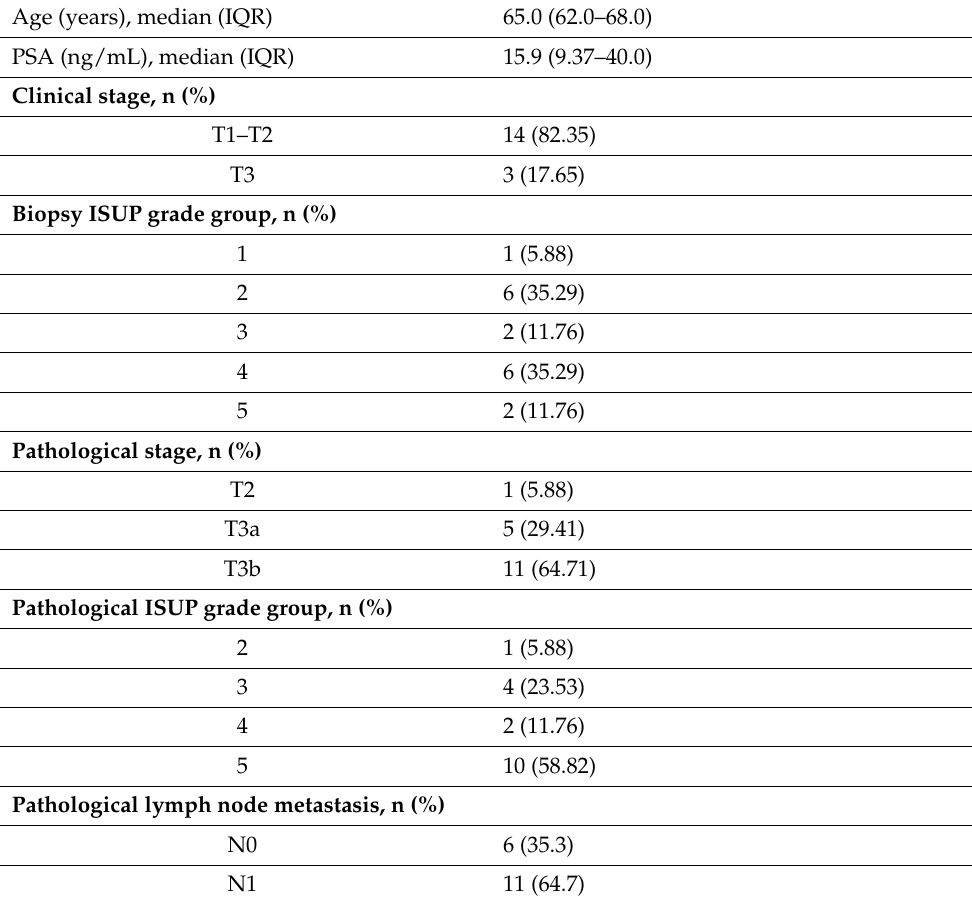
Table 1 lists baseline characteristics of patients. Table 1. Baseline characteristics of the